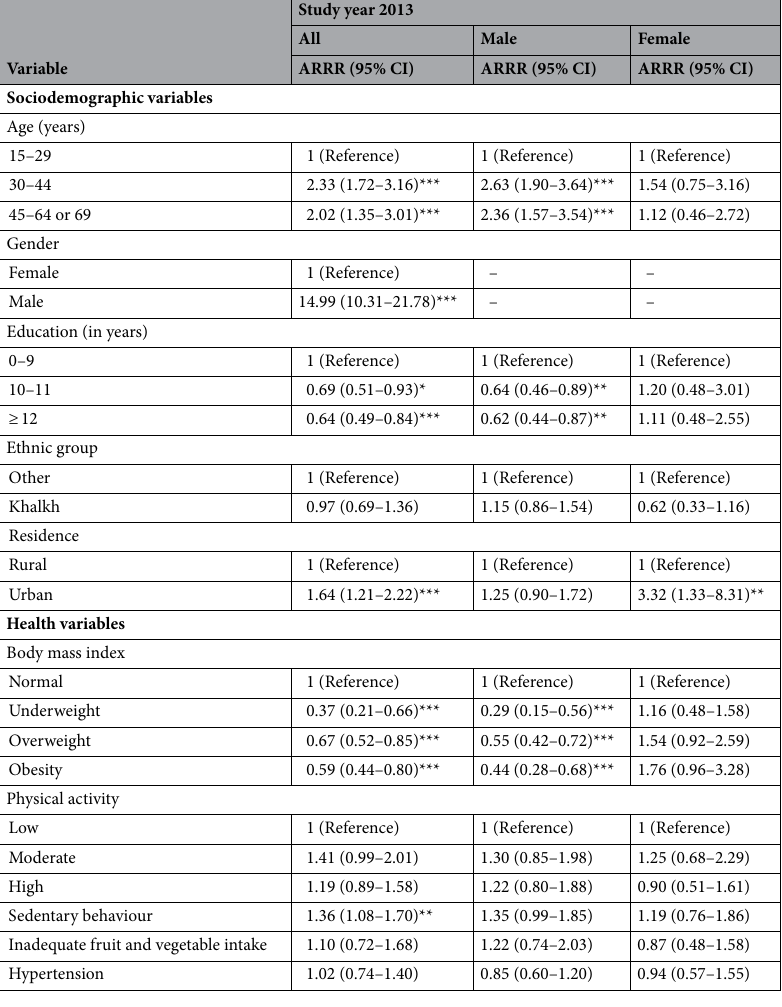
Table 9. Associations with current tobacco use only (with non-current tobacco and non-current heavy drinking as reference category) among 15 years and older individuals in Mongolia, 2013. *** p <